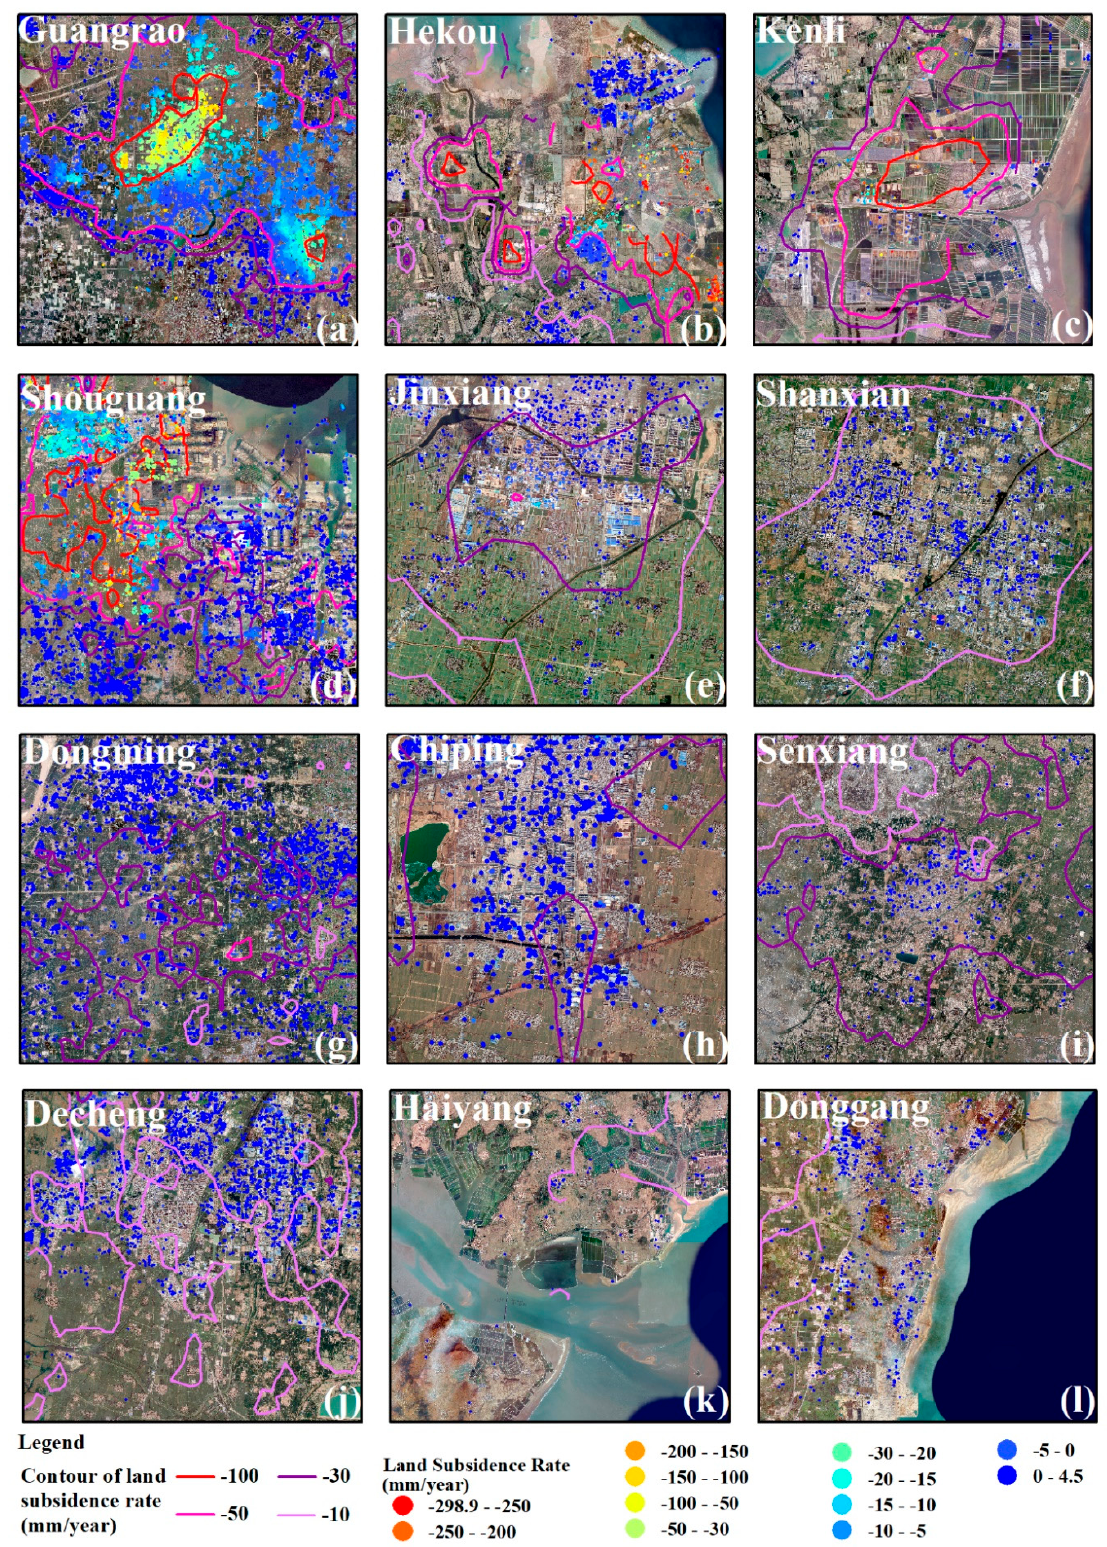
Figure 10. Twelve typical subsidence areas where groundwater has been overexploited.